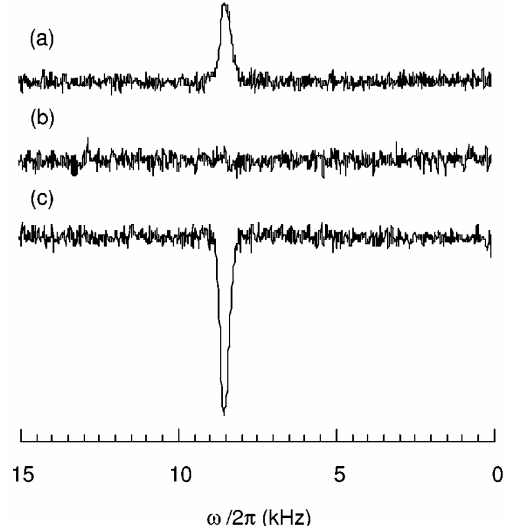
Figure 9. 113 Cd NMR spectra of the high-resistivity CdS single crystal recorded at 2 K. The Boltzmann signal is shown in ( a ), the optically enhanced signal after an irradiation time τ L = 5600 s at 2.60 eV with circularly polarized light and 520 mW laser power ( c ). The control measurement ( b ) was obtained under the same conditions as ( c ) but with the shutter closed during τ L . (Reprinted figure with permission from Reference [32] © (1999) by the American Physical Society).